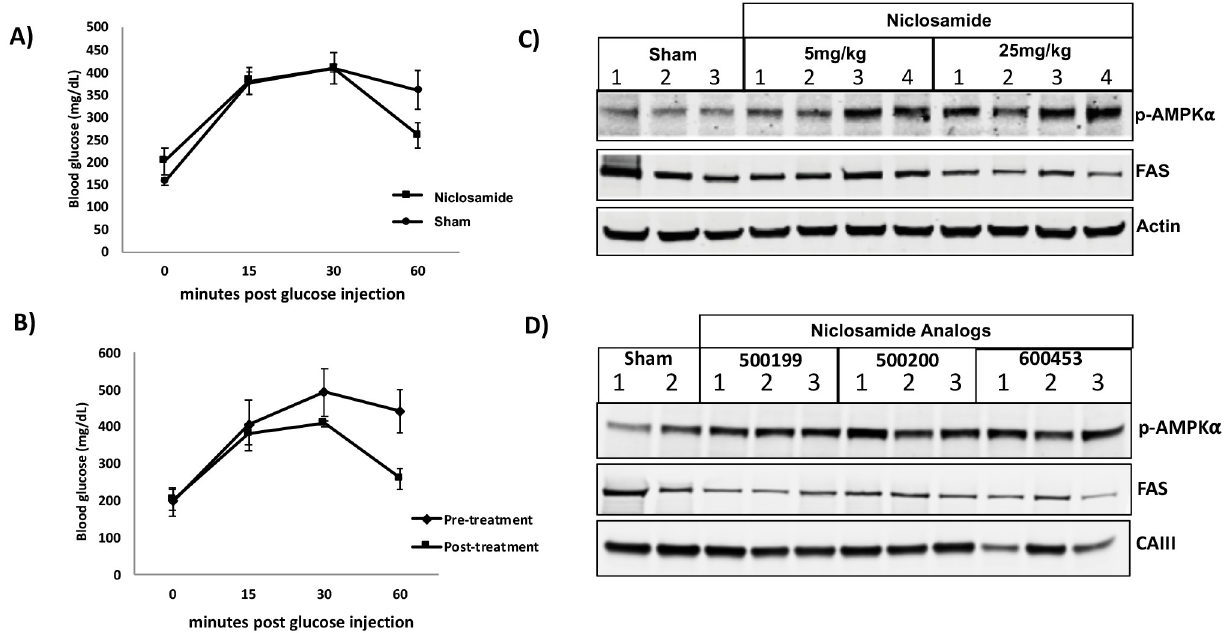
Fig 6. Niclosamide improves glucose tolerance and alters biomarkers of NAFLD and hepatic steatosis. Glucose tolerance test in DIO mice. 2g/kg of glucose was injected IP and at 15, 30 and 60 min, blood glucose levels were measured. (A) Averaged glucose tolerance for 7-day sham cohort and 5 mg/Kg Niclosamide treatment group (n = 3 each, P = 0.05). (B) Comparison of pre and post-7 day treatment with 5 mg/kg Niclosamide (n = 3, P = 0.034). C) Western blot analyses of phosphorylated AMPK α T172, Fatty acid synthase (FAS) and carbonic anhydrase III (CAIII) protein expression in liver tissue samples from male C57BL/6J mice fed HFD treated with 10mg/kg Niclosamide or D) 500200, 500199 or 600453 for 12 days relative to Sham HFD alone (control).